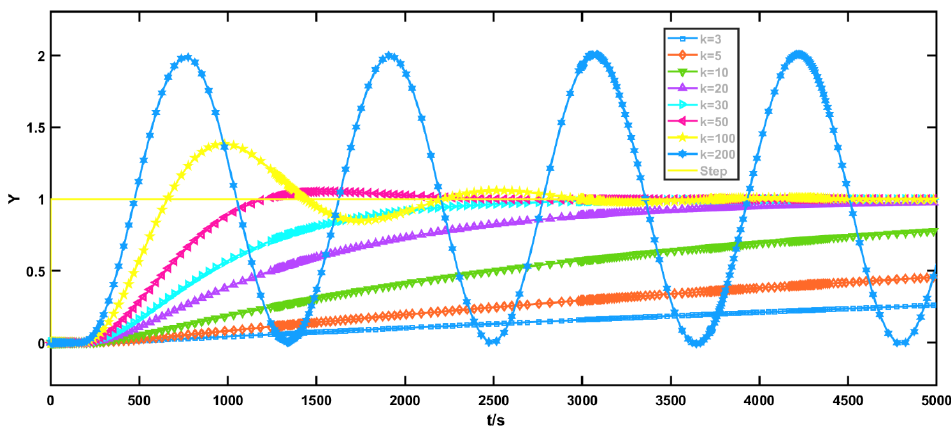
Figure 15. Step Response of a Second-Order Time-Delay System for Di ff erent K when ω c = 0.0473.